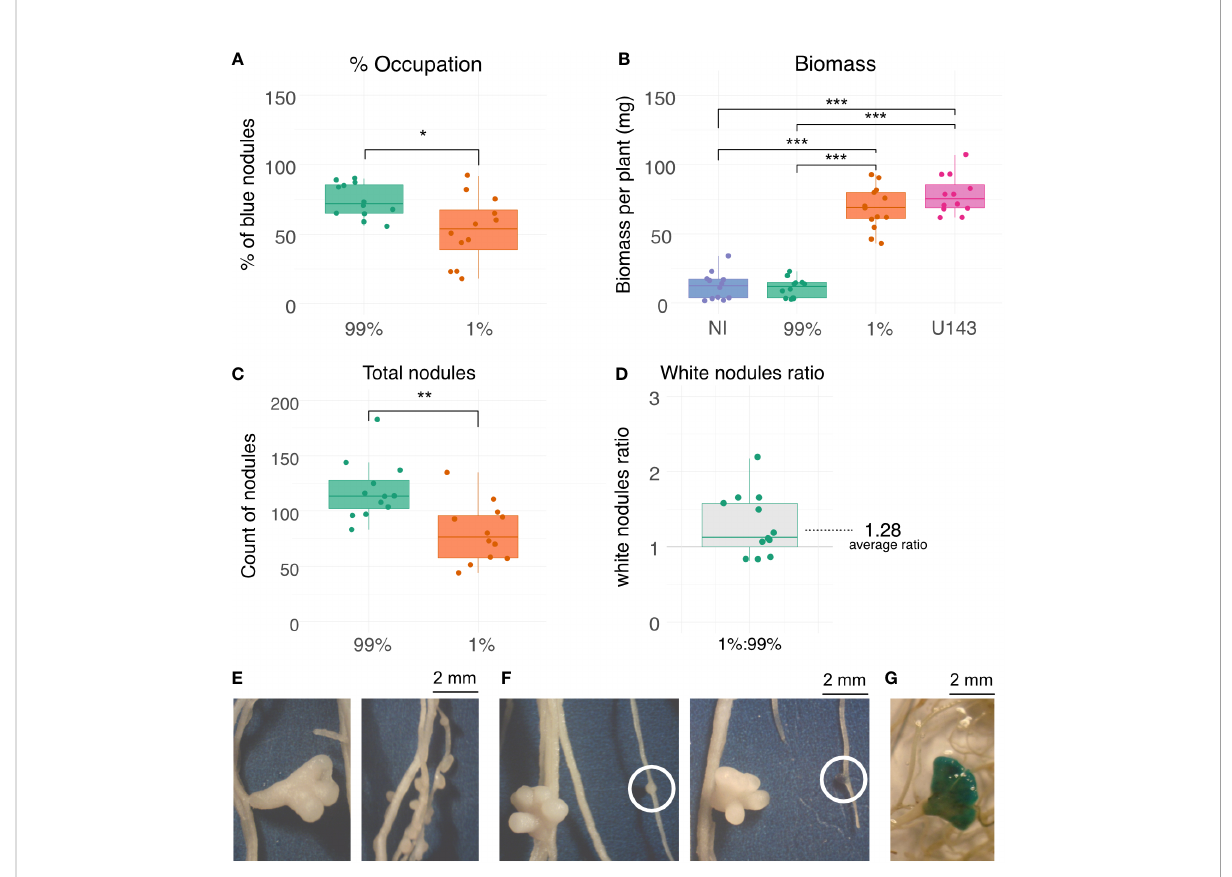
FIGURE 3 Competitiveness, biomass production and nodule morphology in plants inoculated with parasitic and ef fi cient strains. (A) Nodule occupation percentage by tagged strain ORY1:: gusA respect to total nodules. (B) Aerial biomass production. (C) Number of total nodules. (D) White to total nodule ratio. (E) Nodule aspect of those occupied by inef fi cient and ef fi cient strains (left and right, respectively). (F) GUS staining of nodules (left prior staining, and right after staining). (G) GUS staining of a nodule presenting a different morphology (U143 induced morphology-like). 99% and 1% correspond to co-inoculations with a ratio 99:1 and 1:99 of ORY1:: gusA and U143, respectively; NI, non-inoculated control; U143, inoculated with the ef fi cient strain used as commercial inoculant. *, p value < 0.05; **, p value < 0.01; ***, p value <